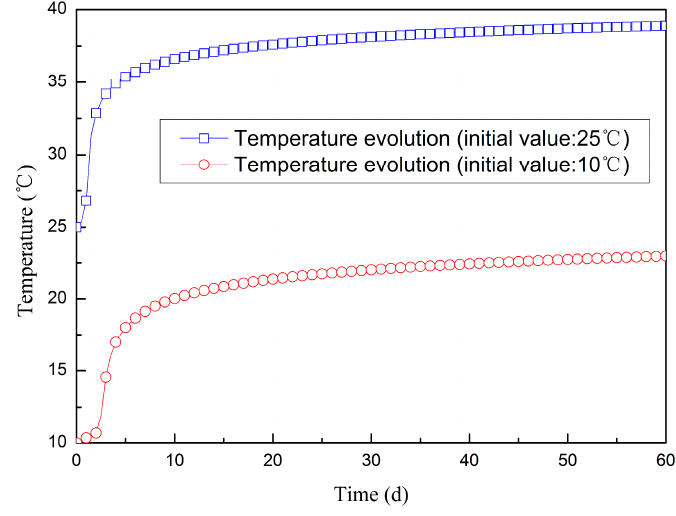
Figure 19. Temperature evolution of SSC concrete under adiabatic conditions.